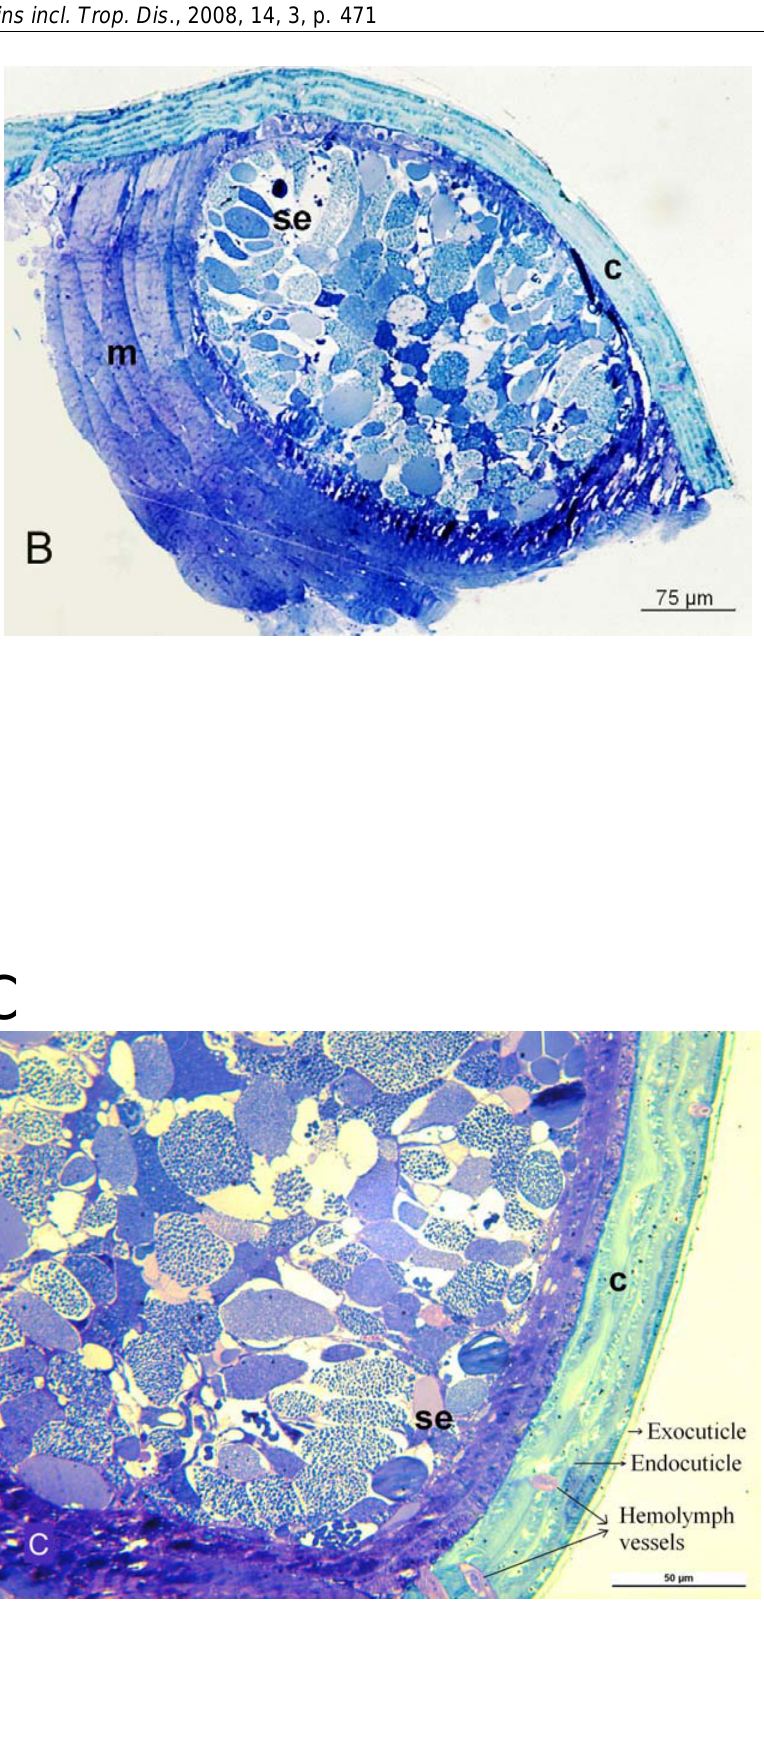
N. Yigit and M. Benli THE VENOM GLAND OF THE SCORPION SPECIES Euscorpius mingrelicus (SCORPIONES: EUSCORPIIDAE): MORPHOLOGICAL AND ULTRASTRUCTURAL CHARACTERIZATION.